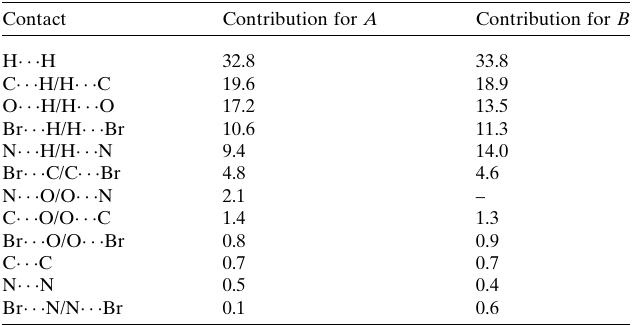
Table 3 Percentage contributions of interatomic contacts to the Hirshfeld surfaces of molecules A and B of the title compound.